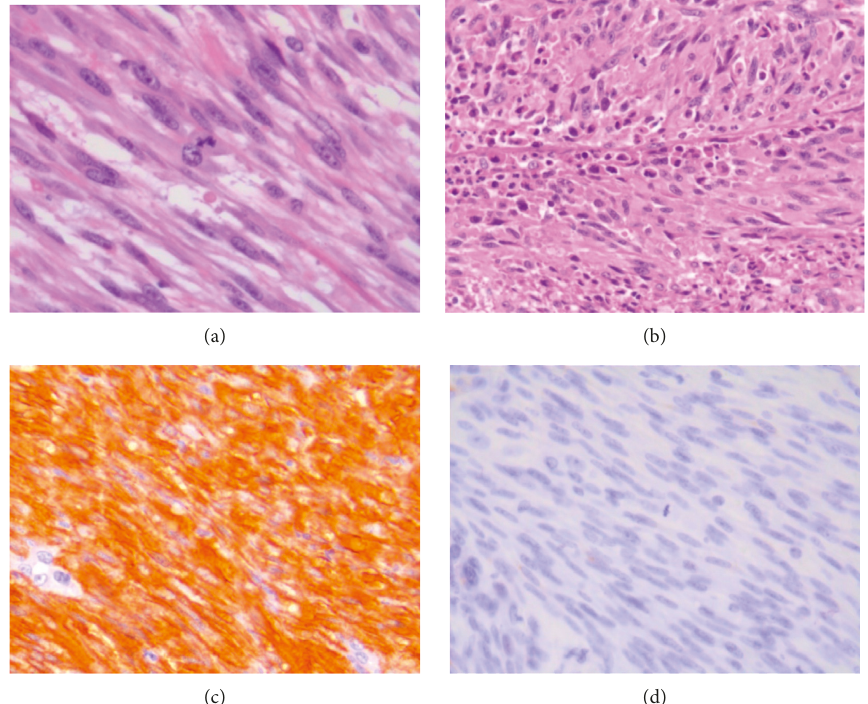
Figure 1: Leiomyosarcoma of the colon. (a) Fascicular tumor cell growth with high mitotic rate(H&E stain, originalmagnification × 630). (b) Tumor cell necrosis (H&E stain, original magnification × 400). (c) SMA staining positive ( × 400). (d) c-kit/CD117 staining negative ( ×